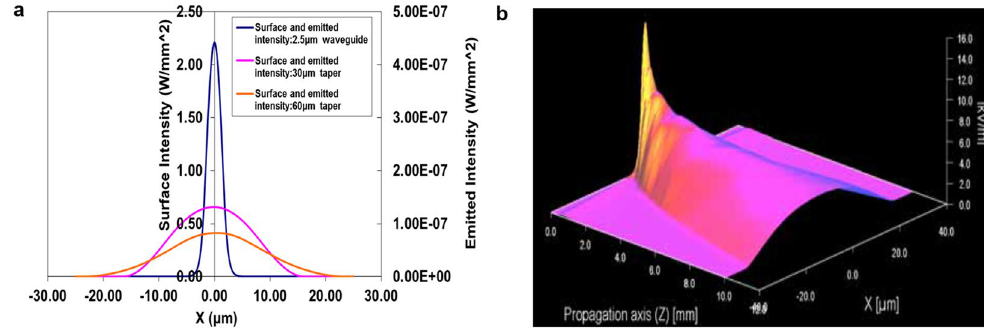
Figure 2. ( a ) Surface intensity of the start (2.5 µ m) and the end of 30 µ m and 60 µ m tapered waveguides in the lateral direction and emitted fluorescence intensity; ( b ) Electric field strength at the surface of a waveguide tapered from 2.5 µ m to 60 µ m over 10 mm.